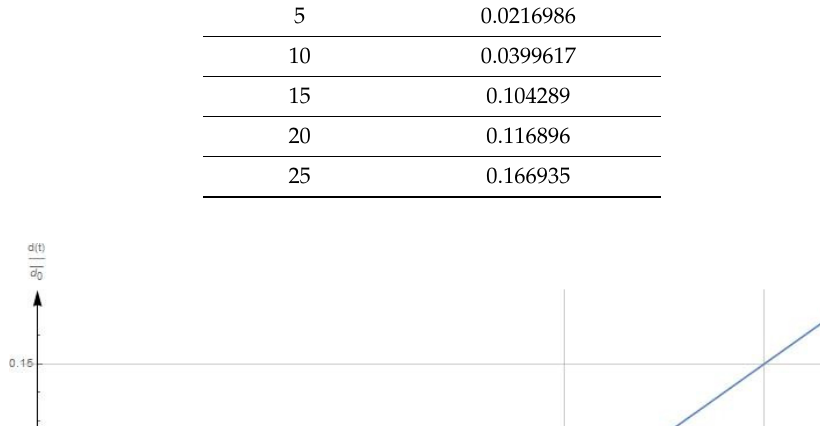
Table 8. Average values of (cid:3031)((cid:3047))